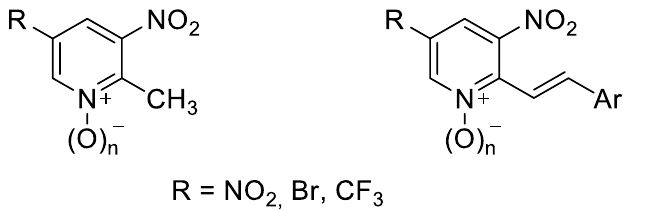
Figure 1. 2-Methyl- and 2-(2-arylvinyl)-3-nitropyridines synthesized and studied in this